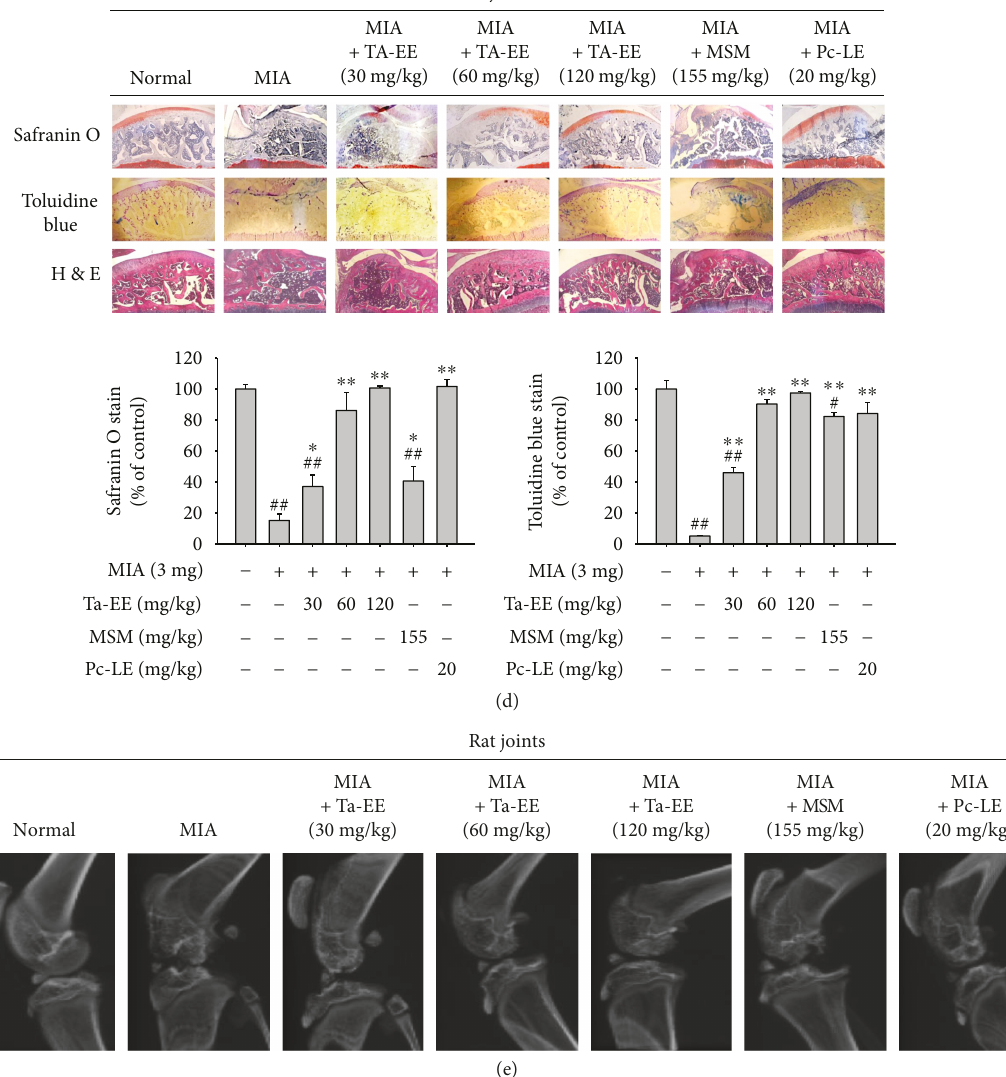
di fl uoride membrane by electroblotting. The protein- transferred membrane was blocked using 5% BSA in PBS at room temperature for 1 h followed by incubation with the primary antibodies speci fi c for each target for 1 h at room